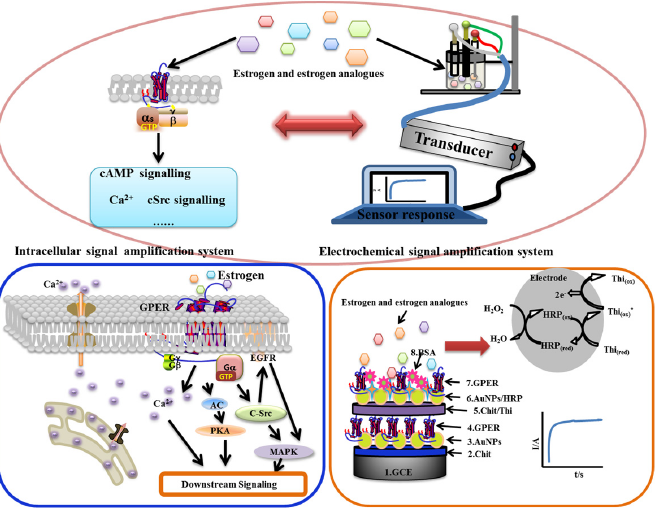
Figure 14. Schematic diagram of measuring principle of GPER electrochemical receptor sensors.